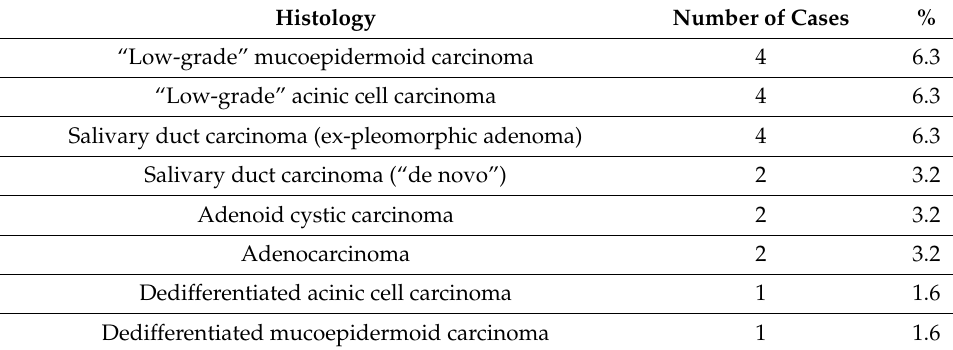
Table 2. Histology of the malignant tumors of our study